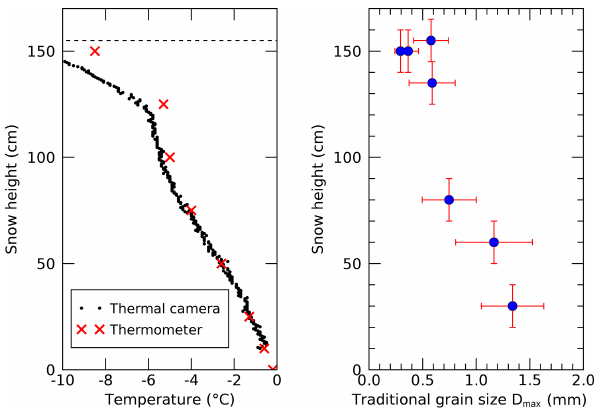
Figure 2. Snow temperature and grain size in the study area close to point C in Fig. 1 on 18 February 2021. Snow height is